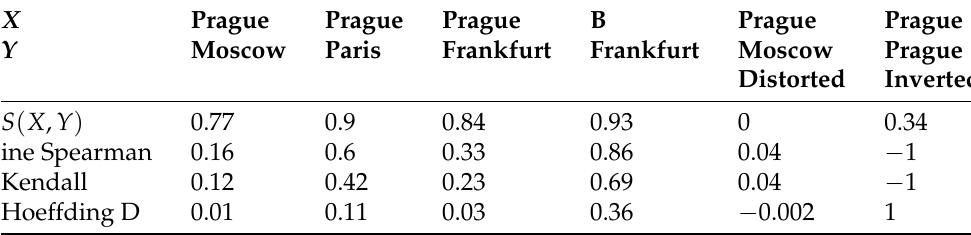
Table 1. Comparison of the similarity index with the known statistical correlation